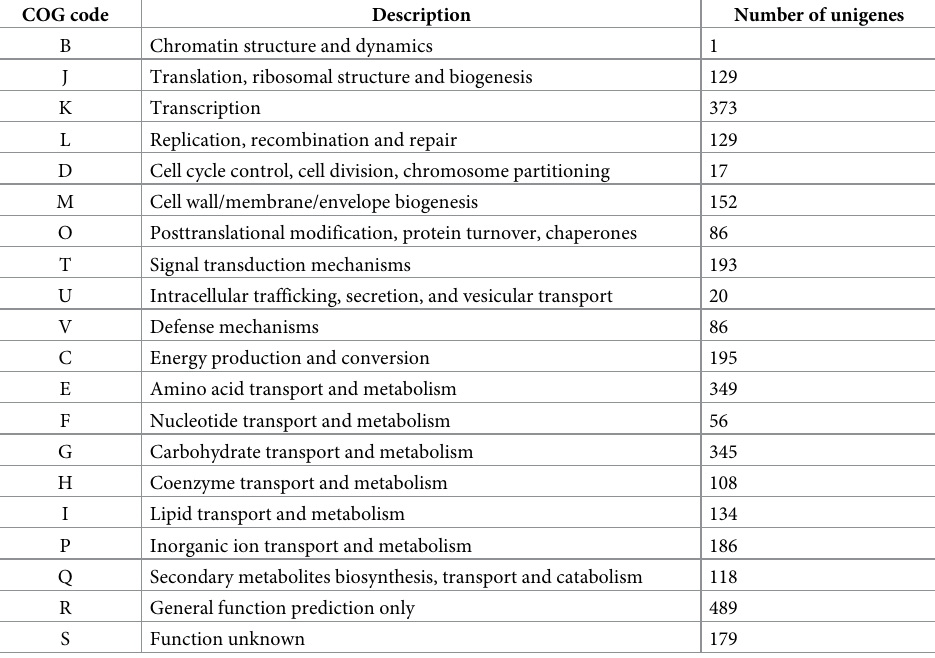
Table 2. COG functional categories of the complete genome sequences of S . niveus SCSIO